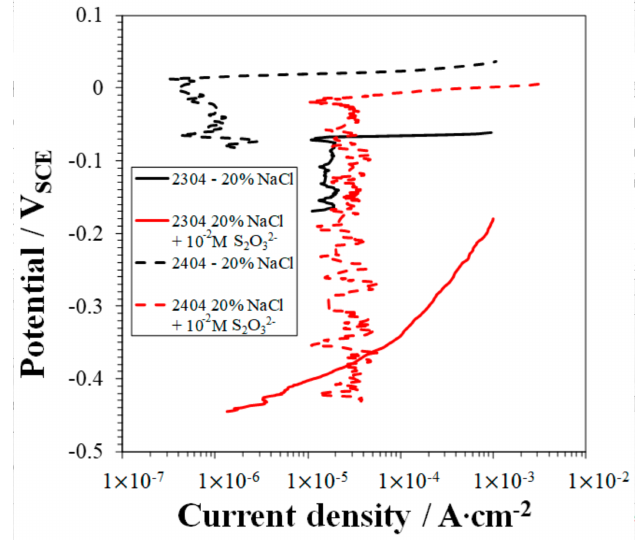
Figure 8. Polarization curves recorded on DSS 2304 and LDSS 2404 after 42 h immersion in 20% NaCl solution at 80 ◦ C, in the absence and in the presence of 10 − 2 M S 2 O 32 −